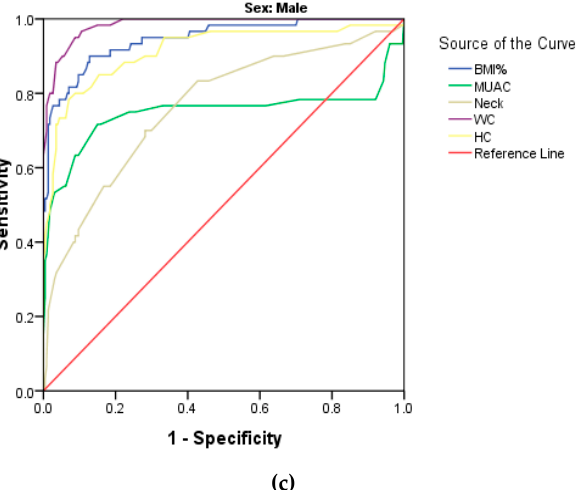
Figure 1. Receiver operating characteristic (ROC) curves for anthropometric measures using WHtR as reference in the cohort, females and males ( a – c ). Table 6. Optimal cut-off, sensitivity, specificity, SE and area under the ROC curves for anthropometric indices in predicting obesity in males, females and cohort using pBMI.